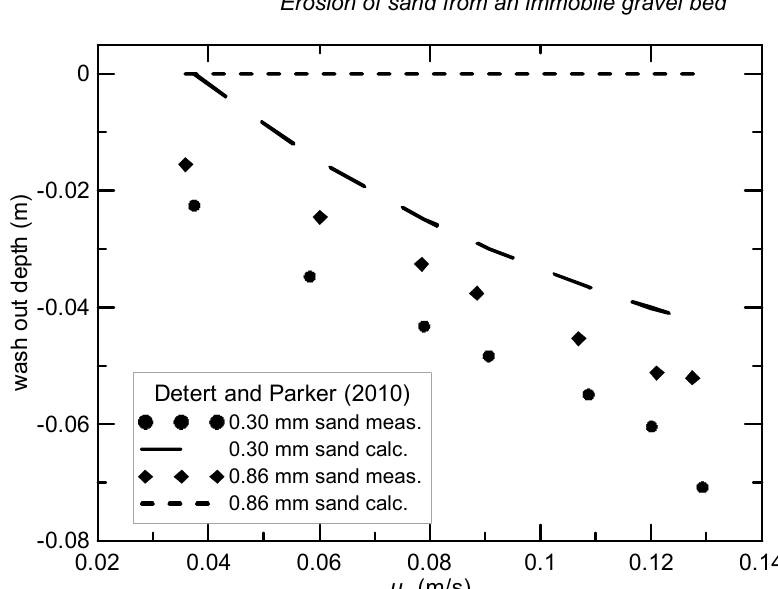
Fig. 1 Measured washout depths from experiments and calculated values from equation (1) of Detert and Parker